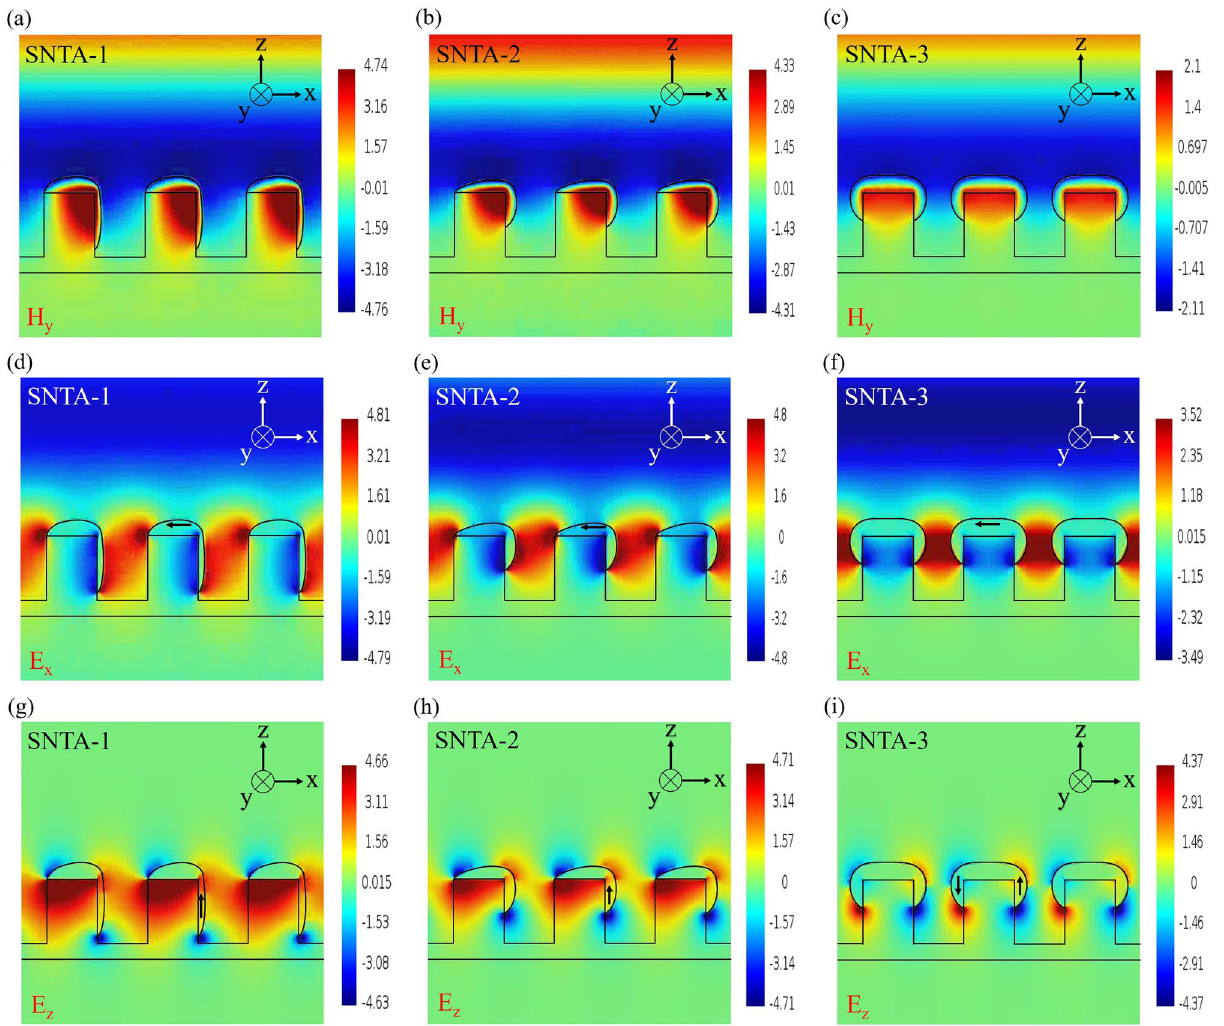
Figure 5. Instantaneously captured images of the oscillating ( a )–( c ) magnetic field, ( d )–( f ) electric field component E x , and ( g )–( i ) electric field component E z for each sample.